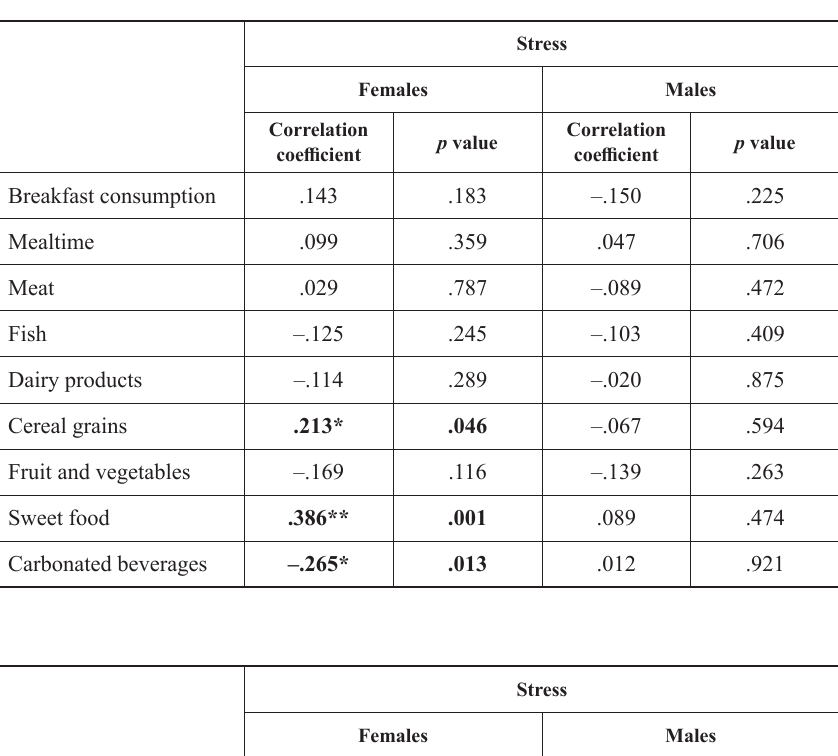
Table 2. Interrelationship between nutrition habits and perceived stress among students